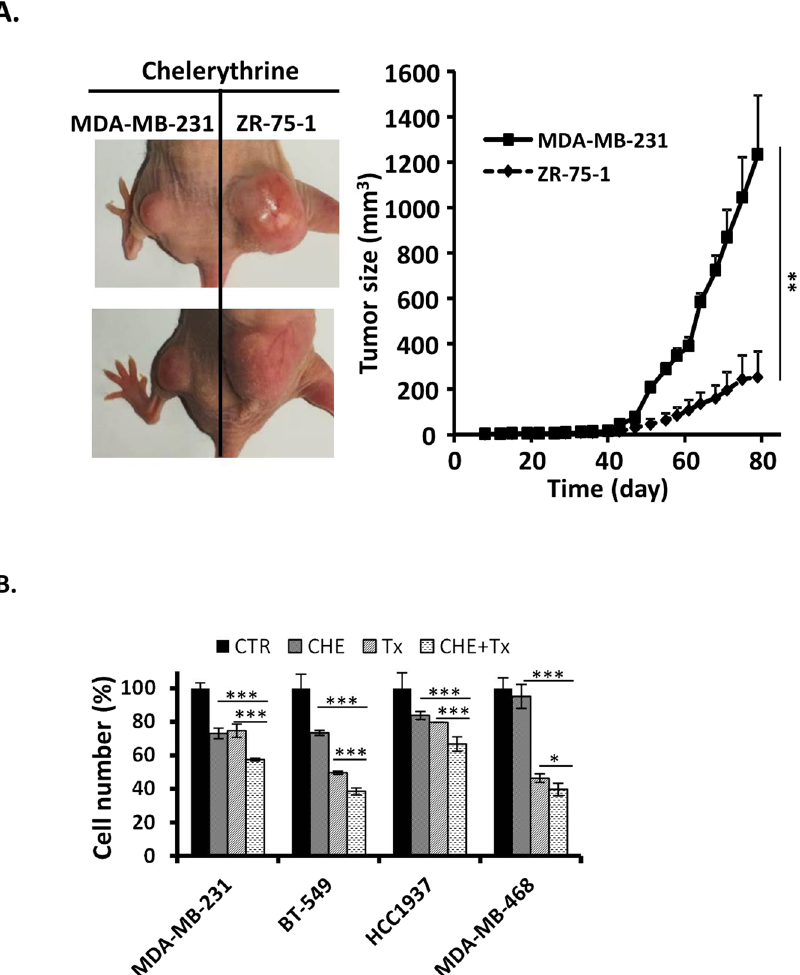
Figure 5. Chelerythrine inhibits xenograft formation of TNBC cells and enhances chemotherapy activity of taxol. ( A ) TNBC cell MDA-MB-231 and non-TNBC cell ZR-75-1 were injected subcutaneously into each hind limbs of nude mice and chelerythrine was administrated intraperitoneally at a dose of 5 mg/kg at 3–4 days intervals. Left panel, xenograft pictures of two representative mice. Right panel, tumor growth curve over time (n = 9). P values were calculated on day 79 after cell injection. ( B ) TNBC cell lines (MDA-MB-231, BT- 549, HCC1937 and MDA-MB-468) were treated with either chelerythrine (CHE, 2 μ M) or taxol (Tx, 10 nM) only, or a combination of dual drugs (CHE, 2 μ M + Tx, 10 nM). The cell number is represented as a percentage of control (CTR, no drug treatment). Average values are from three independent experiments performed in duplicate (n = 3). Data are shown as mean ± SD. P-values determined by Student’s t-test. * P < 0.05; ** P < 0.01; *** P < 0.001.